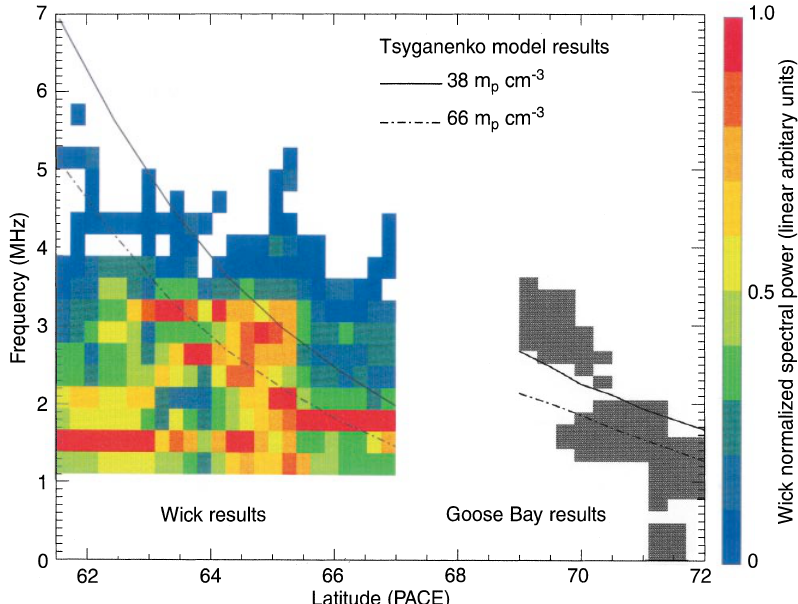
Fig. 1. The latitude dependence of frequency spectra derived from time-series of backscat- tered power from the Wick VHF coherent radar averaged over 16 days, between 0145 and 0245 UT. The spectral power is normalised to 1 for each latitude bin and is displayed as a linear colour scale with red representing the greatest spectral power. Also displayed are previous results from the Goose Bay radar (Samson et al. , 1992, grey shading ), and field-line resonance periods for each latitude, estimated from the T89 model for two plasma-density regimes (see text for details). Note the similarity of the frequencies of the spectral peaks for the two